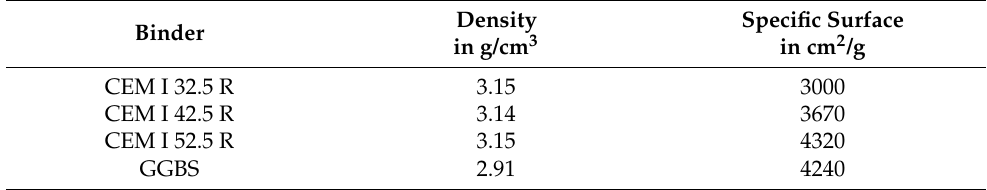
Table 1. Characterisation of the cements and supplementary cementitious